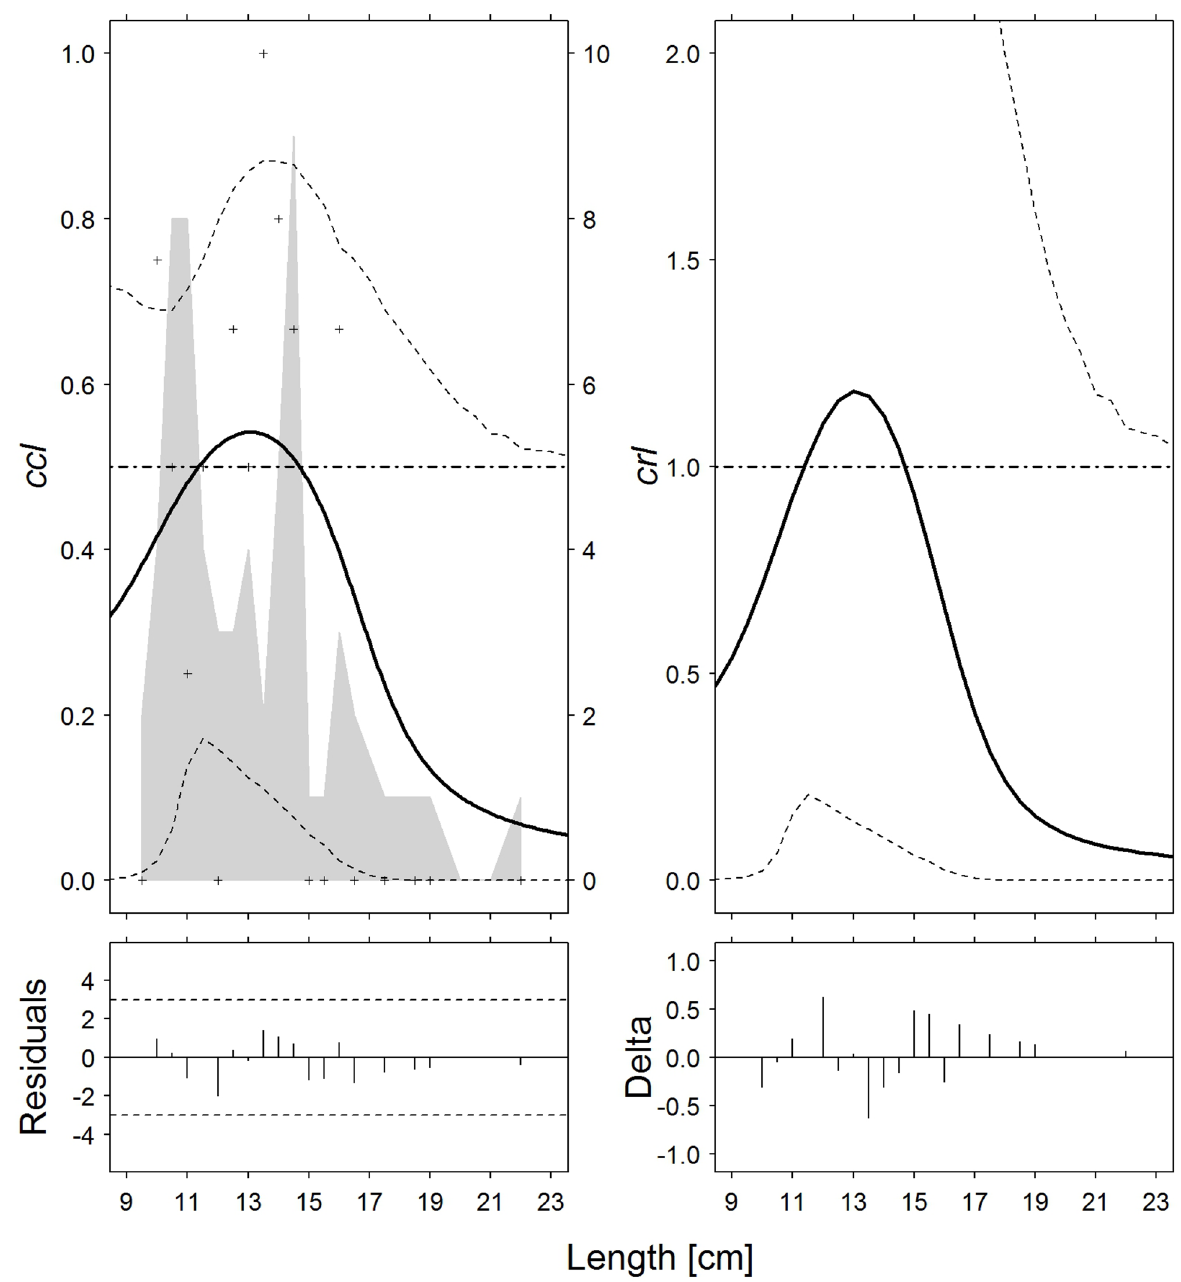
Fig 2. Surmullets ( Mullus spp). Catch comparison rates ( cc , top left )and catch ratio curves ( cr , top right ) of the 30-minute and 60-minute ℓ ℓ tows (solid curves). Crosses: experimental rates; thin dotted curves: 95% confidence intervals; grey solid curve: summed and raised catch populations for all hauls; horizontal dashed line: baseline of no effect on catch performance after changing tow duration. Partial residual plots ( bottom left ) and delta dispersion ( bottom right ) for the two